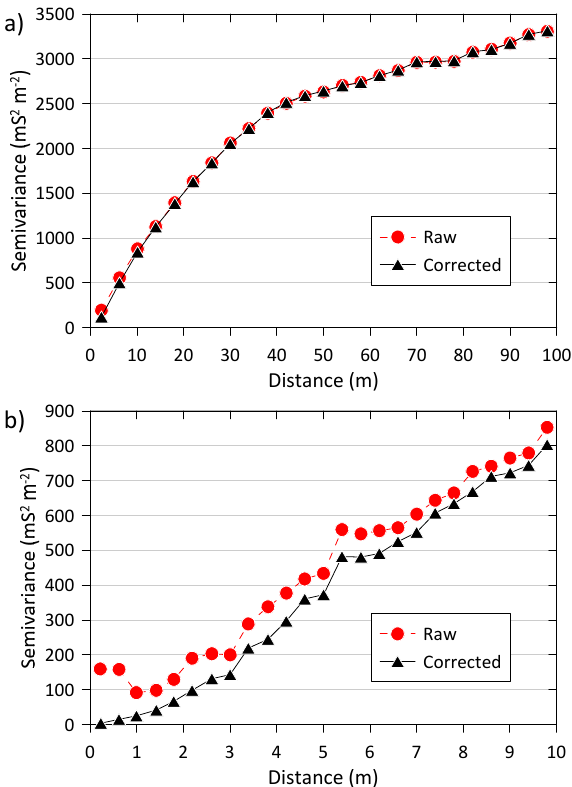
Figure 6. Variograms for the raw and corrected coordinates of the H1 ECa data using data set A + B + C. ( a ) Coarse-scale, up to a maximum lag distance of 100 m; ( b ) fine-scale, up to a maximum lag distance of 10 m.